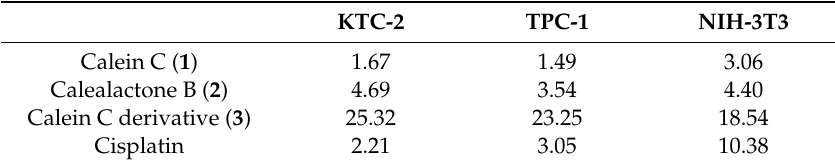
Table 2. IC 50 ( µ M) determined for anaplastic cancer cells (KTC-2), papillary cancer cells (TPC-1) and murine fibroblasts